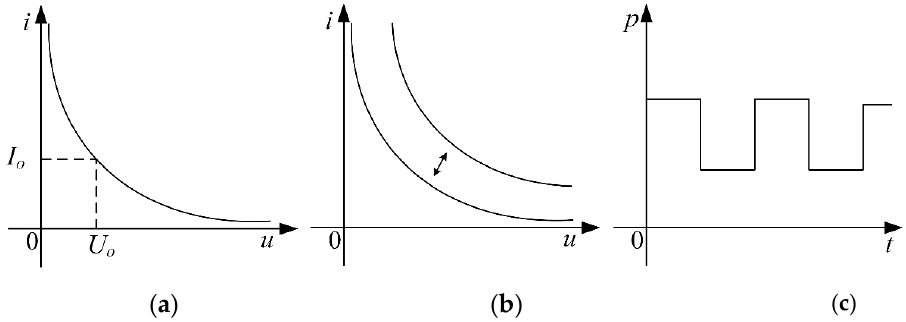
Figure 16. Satellite loads. ( a ) Constant power load; ( b ) Variable power load; ( c ) Variable power load that switches between two powers over time.